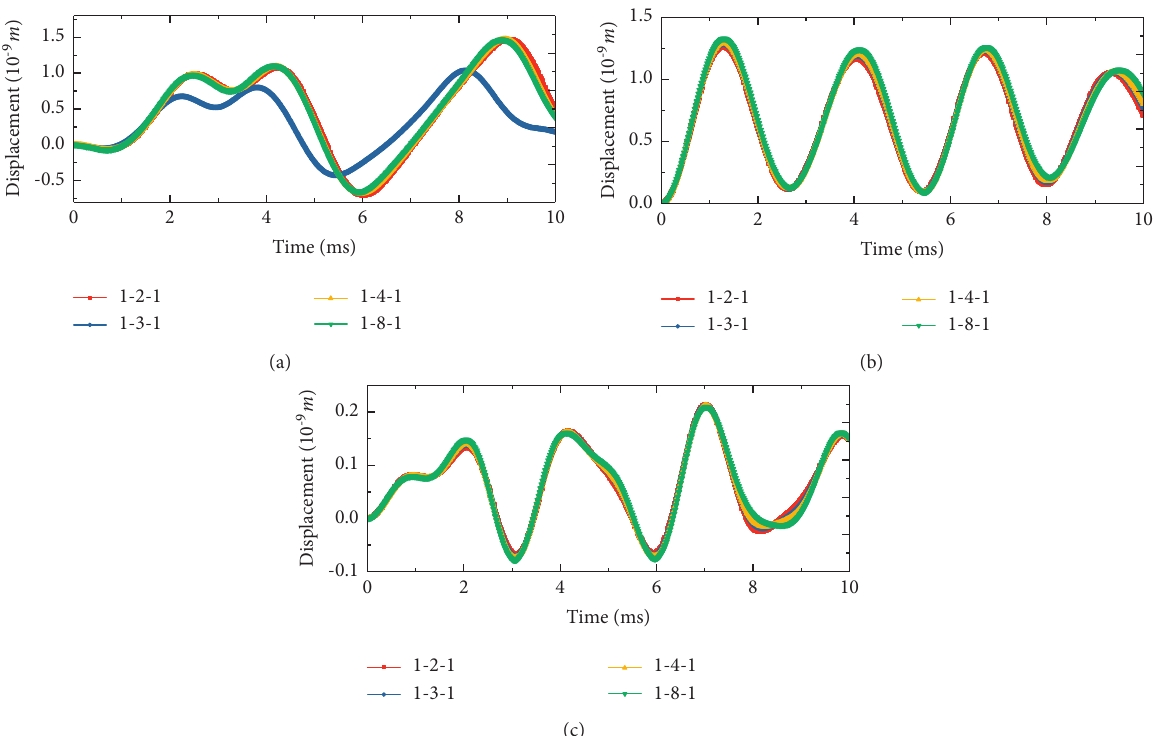
Figure 15: Study on the effect of thickness on the transient response of Sandwich FGP doubly curved structure: (a) Sandwich paraboloidal honeycomb shell; (b) Sandwich hyperbolic honeycomb shell; (c) Sandwich elliptical honeycomb